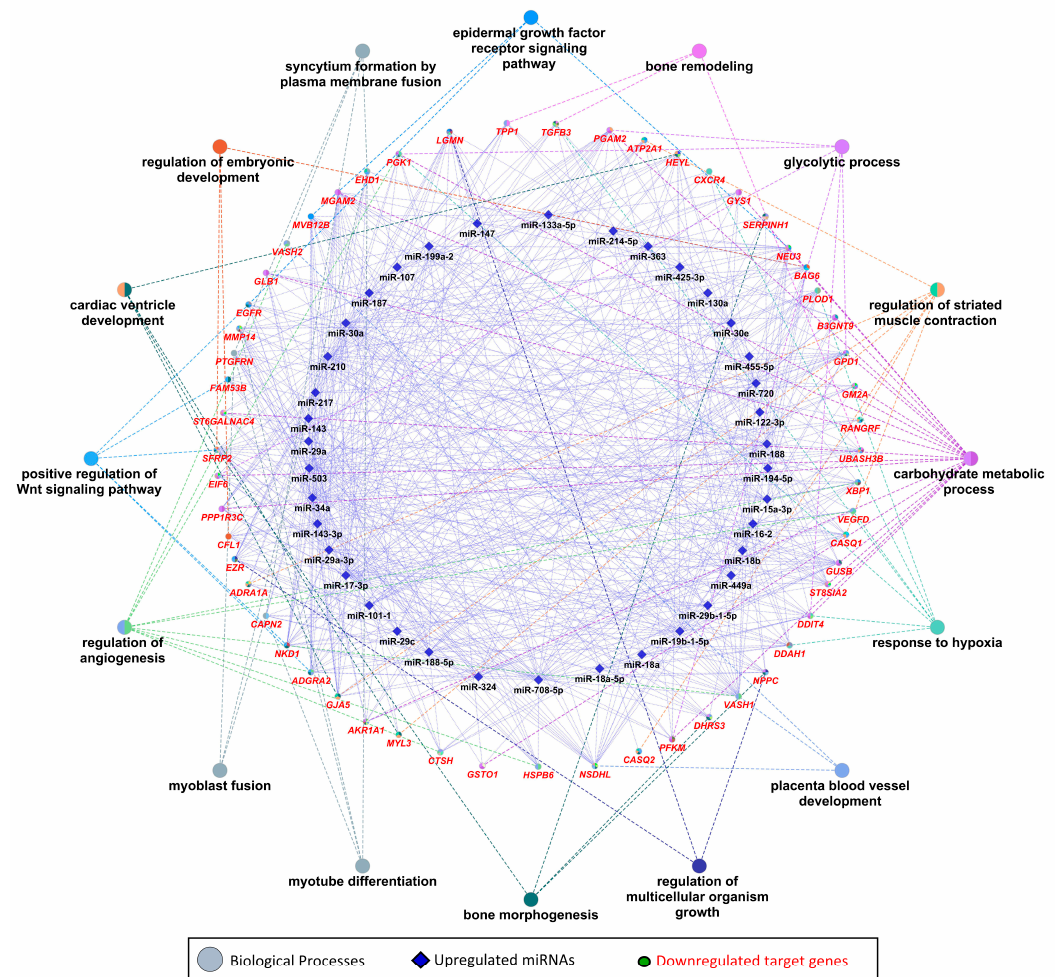
Figure 5. Enrichment analysis of downregulated genes, which are negatively correlated to and targeted by upregulated miRNAs, in gene ontologies for biological processes, derived using the ClueGO (version 2.5.1) and Cluepedia (version 1.5.7) plugin in Cytoscape (version 3.8.2) environment. Eclipses with red labels indicate the genes, and different pie colors in gene shapes indicate their enrichment in multiple biological processes. A complete list of biological processes enriched by downregulated genes is provided in Table S3.